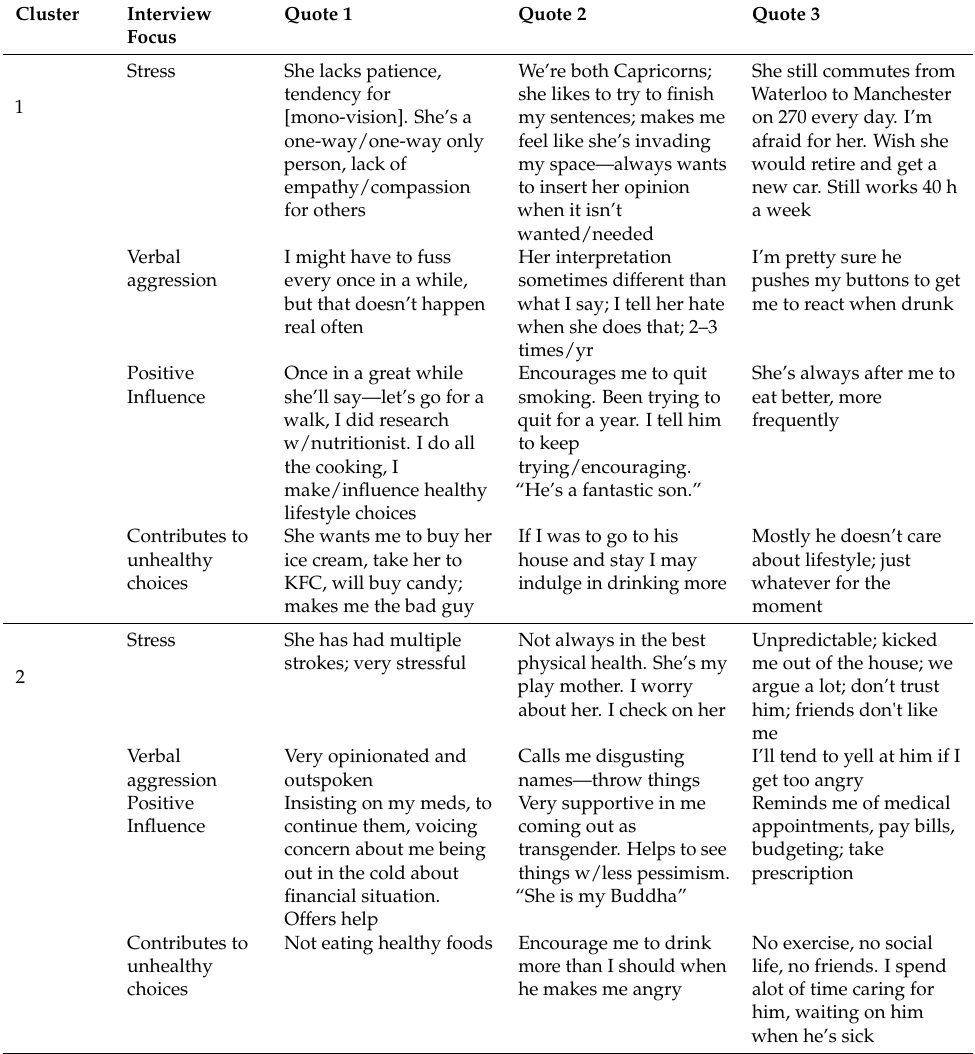
Table 4. Descriptions of most intimate relationship by cluster